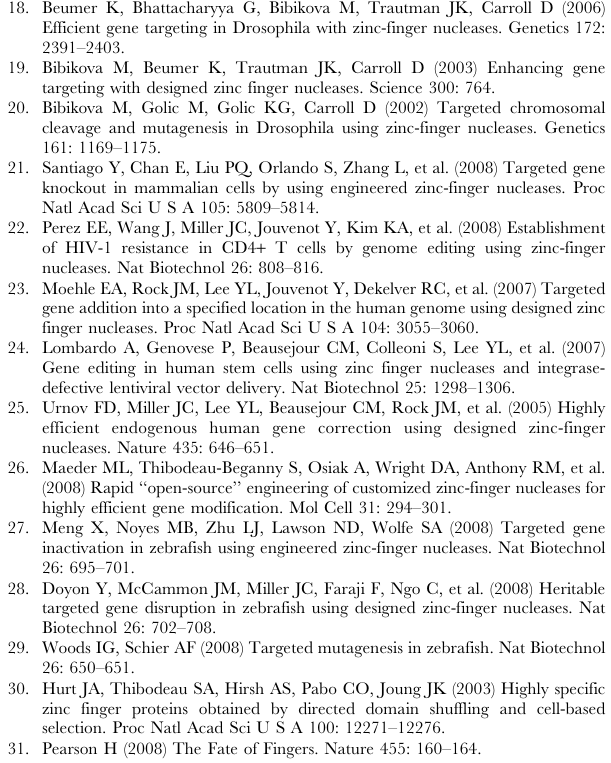
Table S21 Potential OPEN ZFN target sites in gene transcripts encoded on zebrafish chromosome 21. Data presented as described in the legend to Table S1.